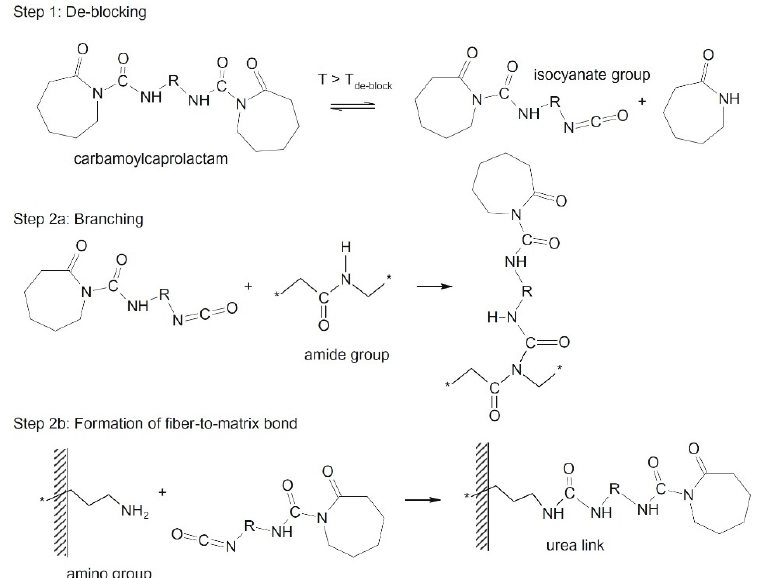
Figure 14. De-blocking of carbamoylcaprolactam ( Step 1 ) and the subsequent formation of branch points ( Step 2a ) or fiber-to-matrix bonds ( Step 2b ). Reprinted from Reference [93], under